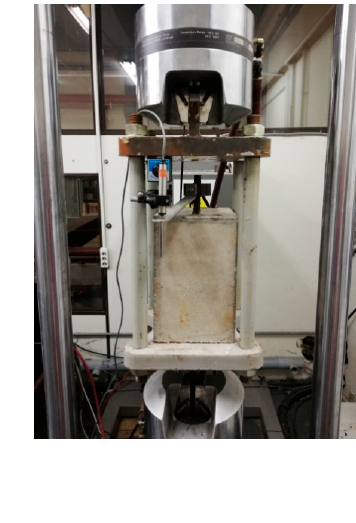
Figure 6. ( a ) Apparatus designed for pull-out testing, in order to transfer the force from reinforcing bar to concrete. ( b ) Experimental pull-out test on semi-embedded steel reinforcing bar.